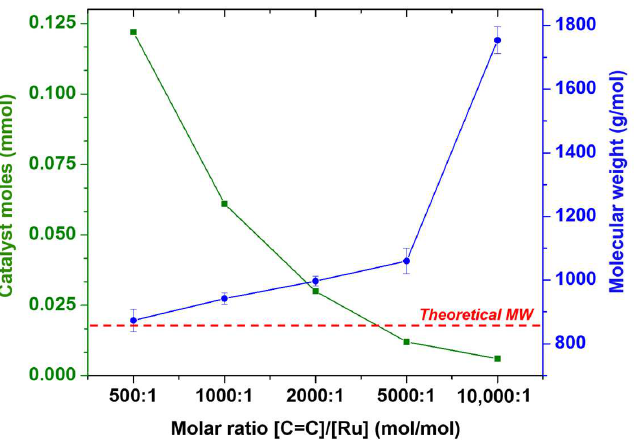
Figure 5. Relationship between molar ratio of catalyst [C=C]/[Ru] with catalyst moles and molecular weight for the synthesis of biobased HTPB. The red line indicates the theoretical molecular weight MW (852 g/mol) for all molar ratios.